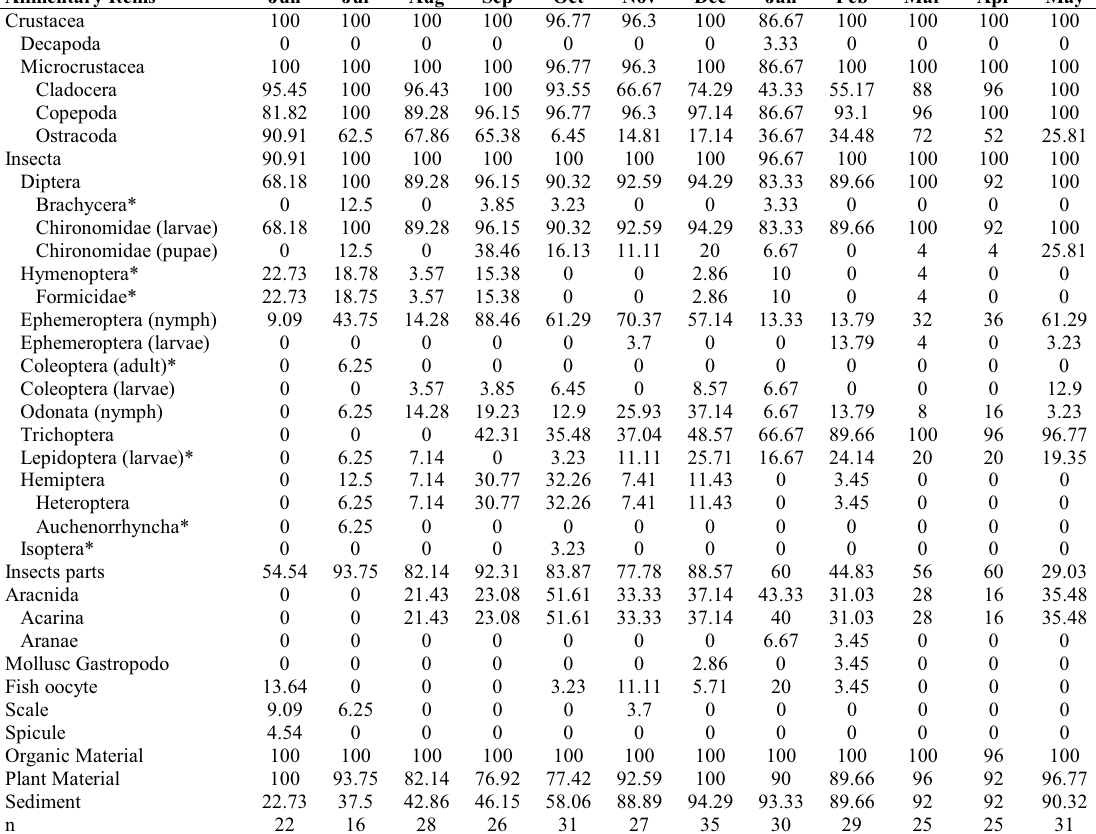
Table 1. Frequency of occurrence of identified food items for E. trilineata adults (*=allochthonous origin). Alimentary Items Jun